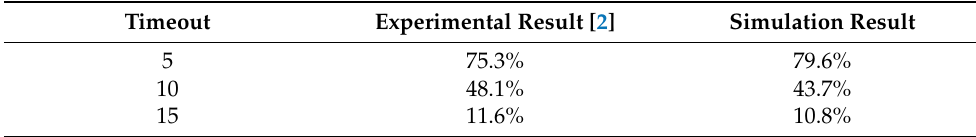
Table 3. Comparison between simulation results and experimental results. Table 3. comparison between simulation results and experimental results.